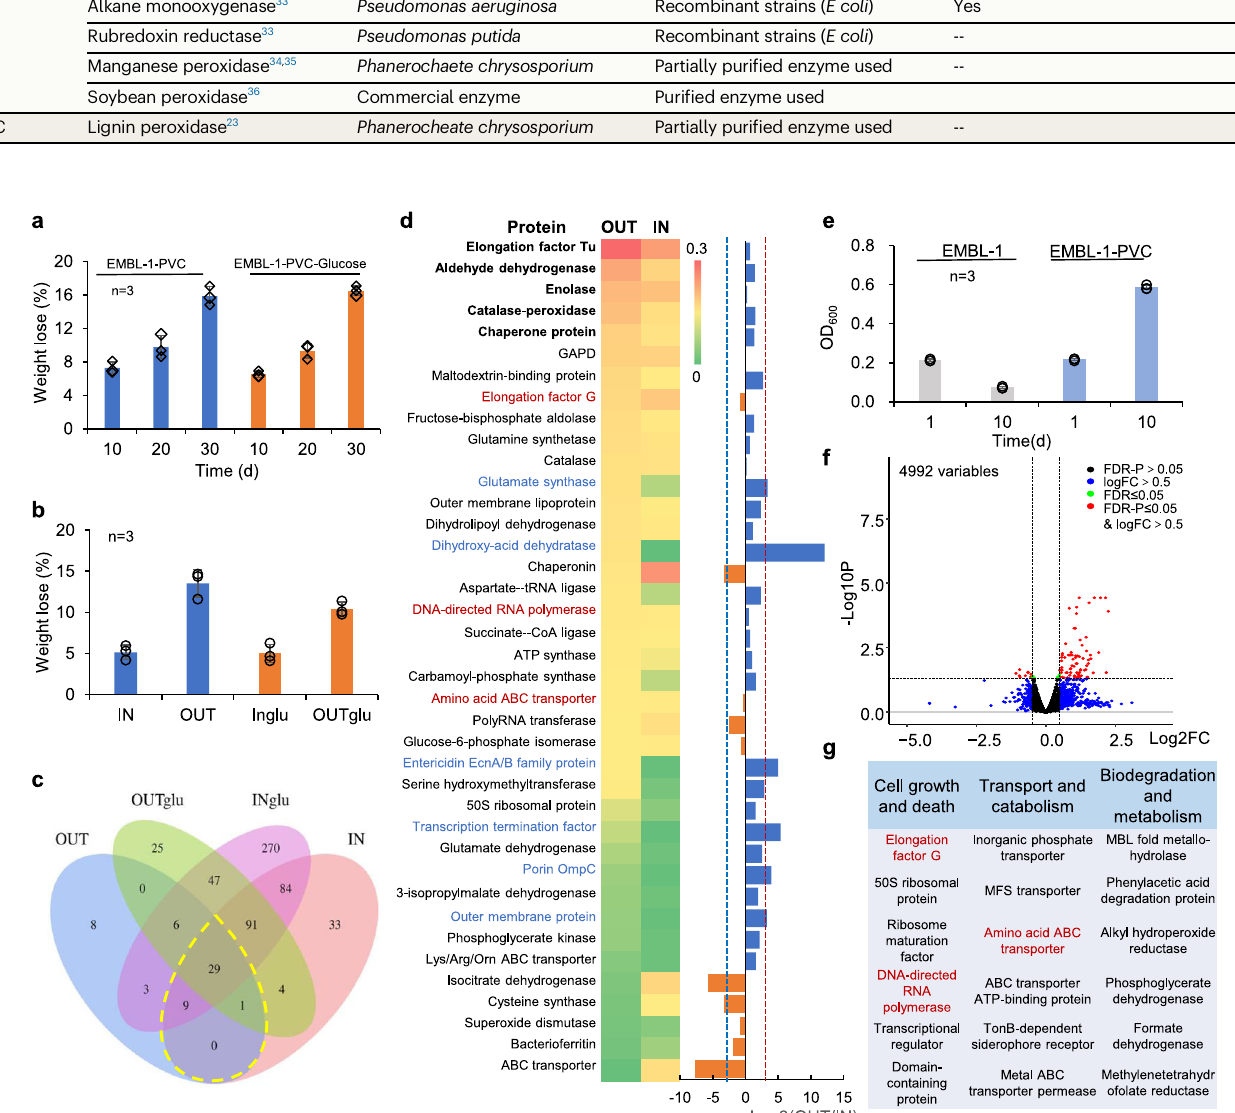
Fig. 4 | Proteomic and transcriptomic analyses of PVC-degrading metabolic functions of strain EMBL-1. a , b The weight loss of PVC fi lm under the action of strain EMBL-1 without and with glucose (glu) as supplementary carbon source ( a ) and four intracellular (IN) or extracellular (OUT) protein extracts under in vitro conditions ( b ). c Venn diagram showing shared and unique proteins in the protein extracts; d